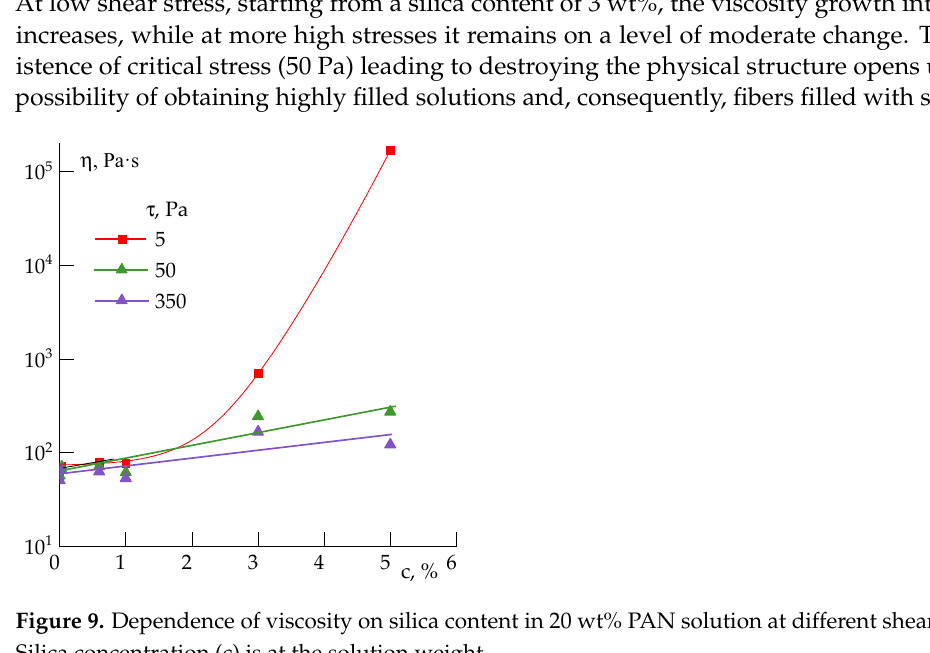
Figure 9. Dependence of viscosity on silica content in 20 wt% PAN solution at different shear stress. Silica concentration (c) is at the solution weight.